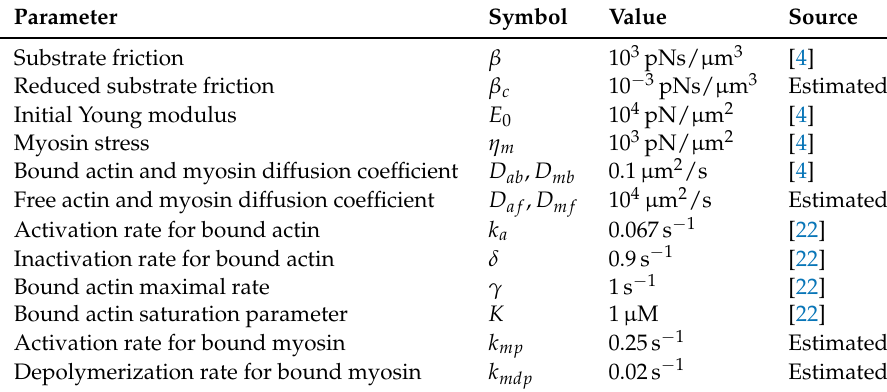
Table 1. Numerical values for the mechanical data and phenomena parameters.